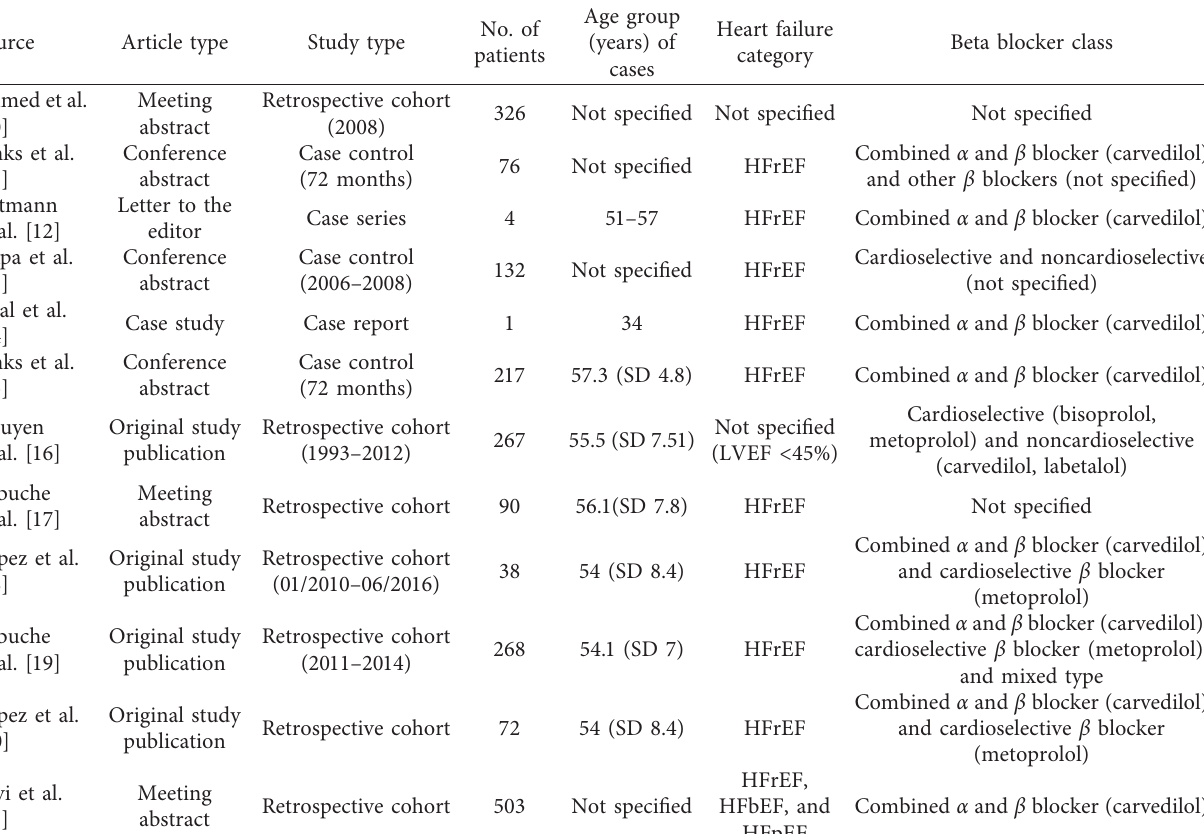
Table 1: Characteristics of studies examining the effect of beta blockers in heart failure patients with active cocaine use.